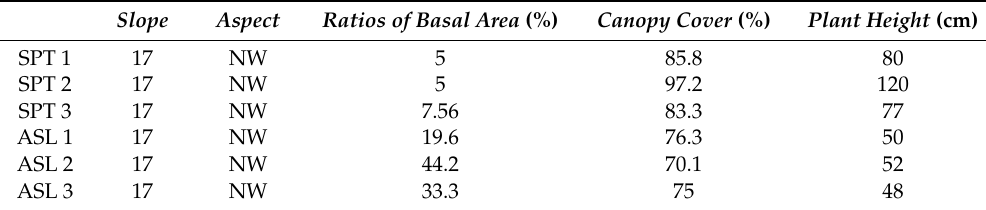
Table 4. Plant traits in plots for runo ff monitoring.